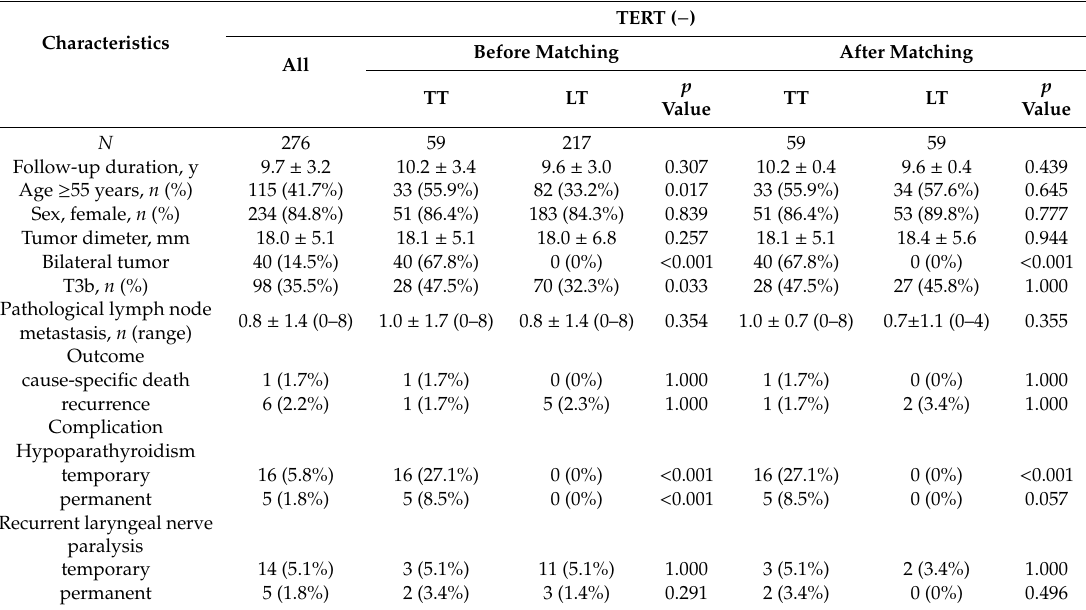
Table 6. Characteristics of patients in the TERT − group before and after propensity score-matching.